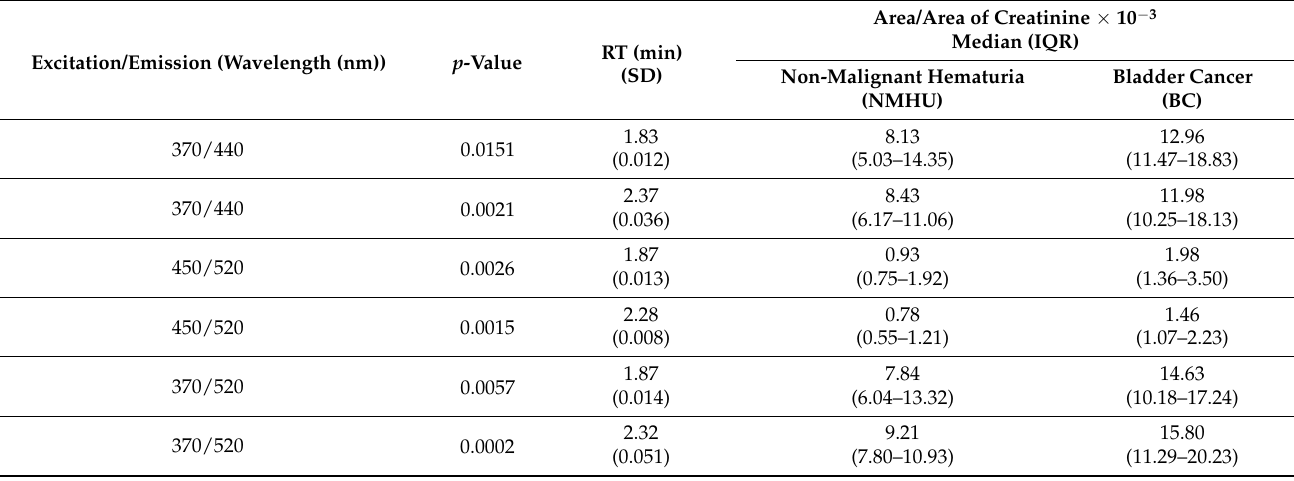
Table 3. Characteristics of fluorescent peaks identified as significantly different for BC and NMHU groups.